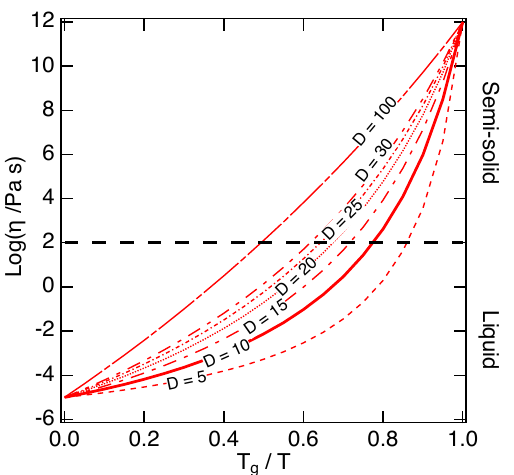
Figure 2. The Angell plot of viscosity ( η) vs. T g /T . The lines repre- sent different fragility parameter ( D) values in the range of 5–100, with D = 10 (the solid line) used as a base case for this study. A large fragility parameter value is associated with a strong glass for- mer, while fragile materials are associated with lower values. The black dashed line at a viscosity of 10 2 Pas indicates the approxi- mate threshold between liquid and semi-solid